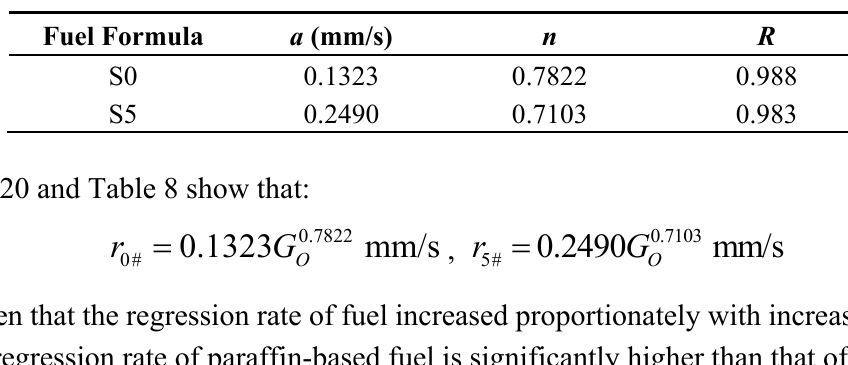
Figure 20. The fitting curve of the fuel regression rate and Go . Table 8. The regression rate parameters of S0 and S5